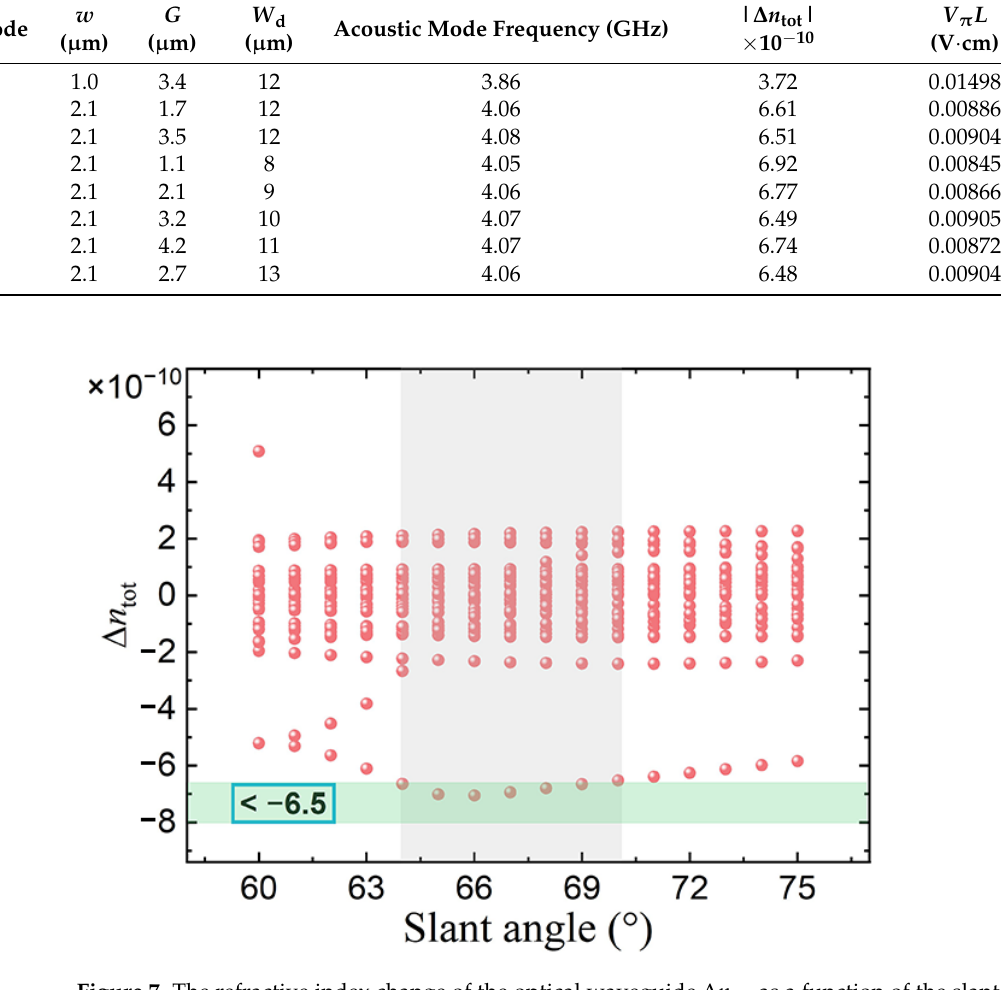
as a function of the slant angle (cid:2930)(cid:2925)(cid:2930)